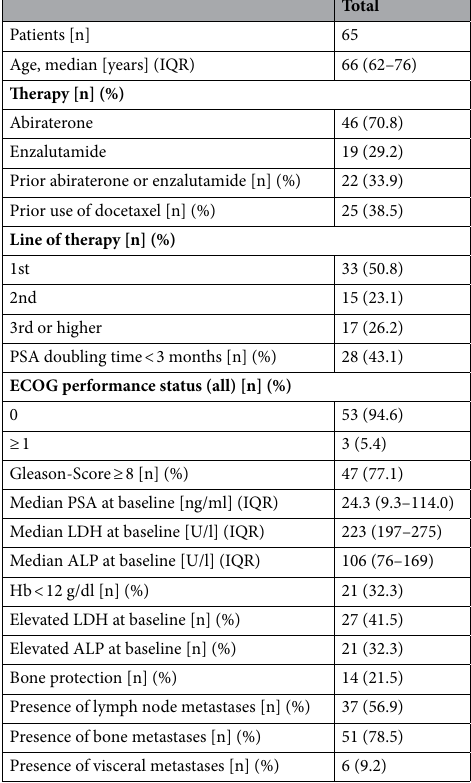
prognostic (Table S5). Within the AR-V7- subgroup, prior abiraterone or enzalutamide ( p = 0.02) was indepen- dently prognostic (Table S6). Overall survival (OS). For the overall cohort, median OS was 20 months (CI 10.5–29.5). By comparing CTC + versus CTC − patients, median OS was not reached for CTC − patients compared to 15 months (CI